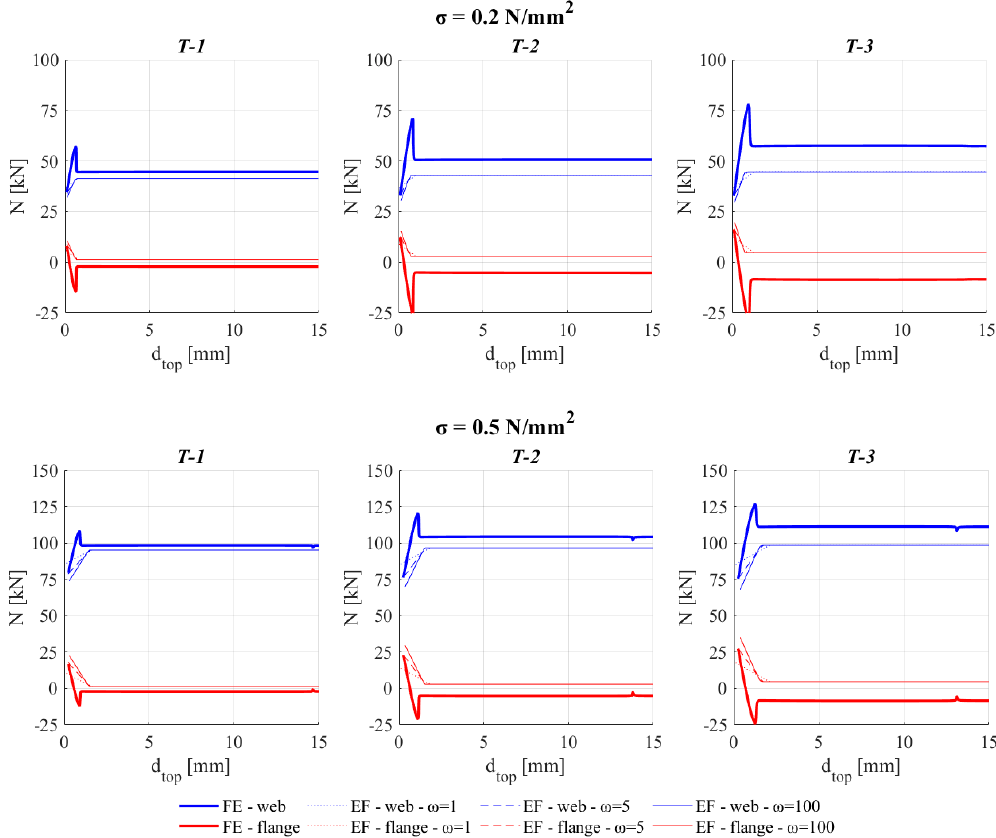
Figure 17. Comparison between FE and EF models in terms of variation of the axial loads on the three components of T-shaped 3D assemblies.